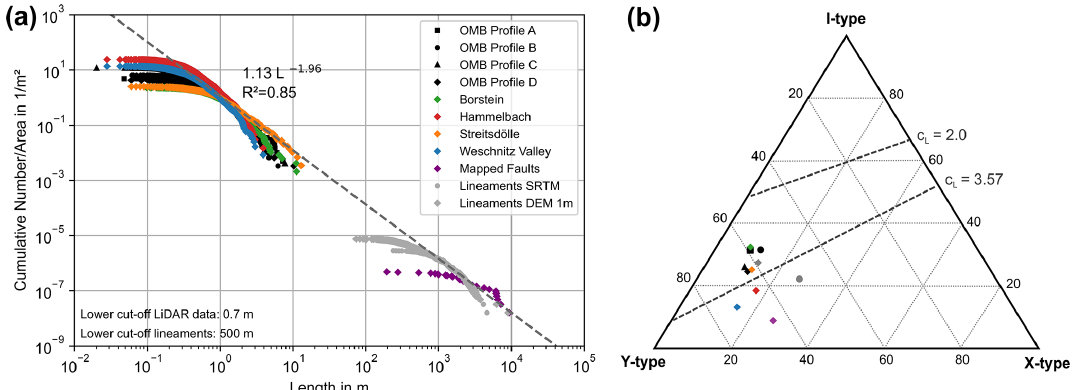
Figure 6. (a) Area-normalized trace length cumulative-frequency plot; (b) triangular plot of the proportions of I-, X- and Y-nodes of the analyzed